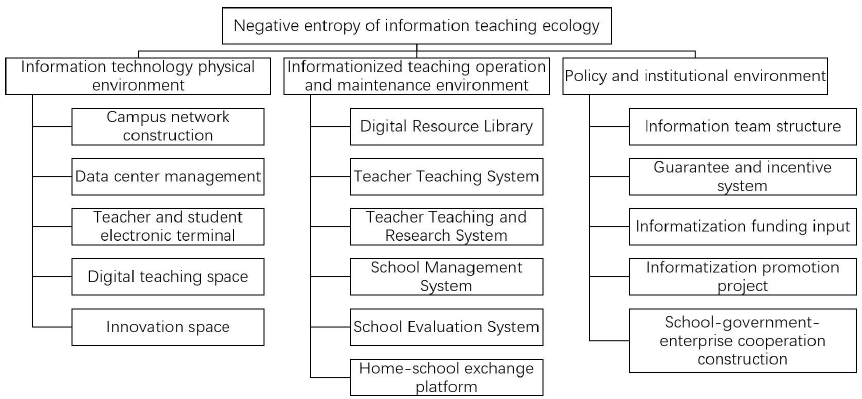
Fig. 3 Ecological negative entropy index system of informatisation